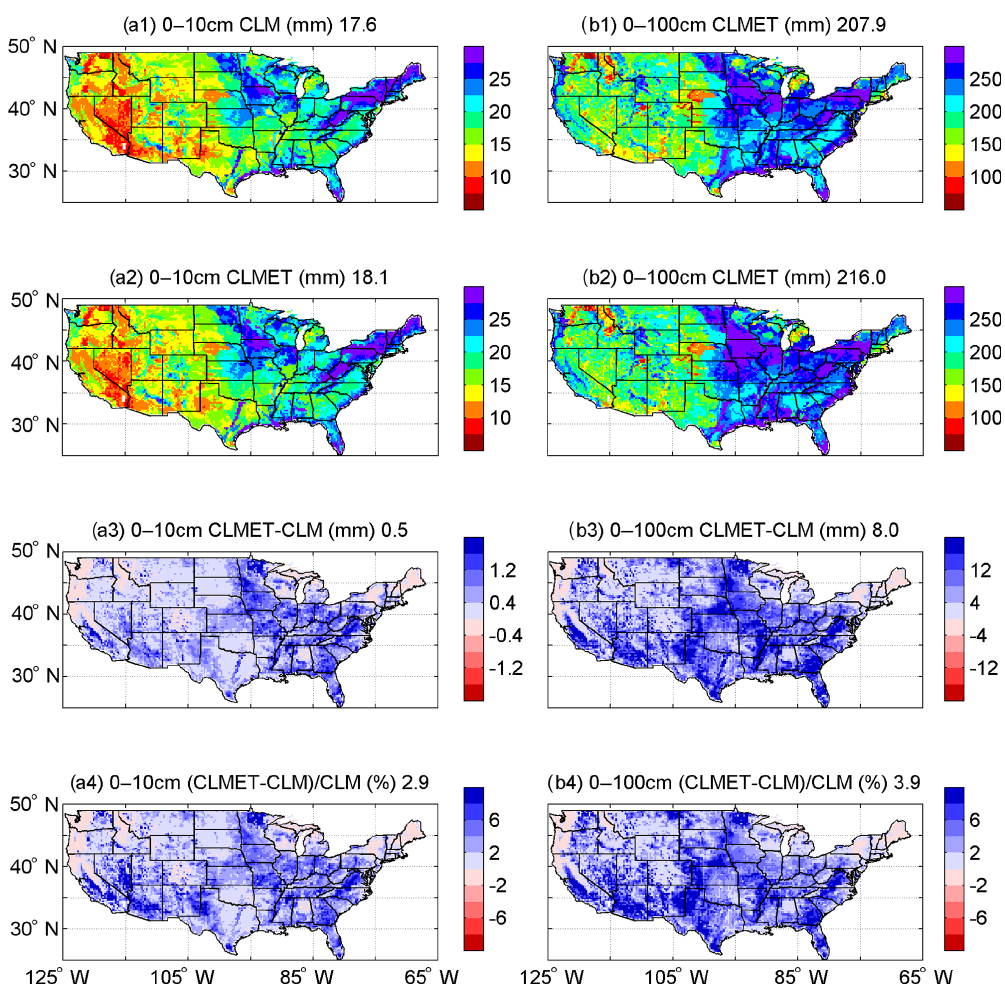
Figure 12. Simulated soil moisture (mm) in the top (a) 0–10cm and (b) 0–100cm layers in August from (1) the CLM and (2) CLMET, (3) their differences, and (4) their relative differences during the period 2000–2014.